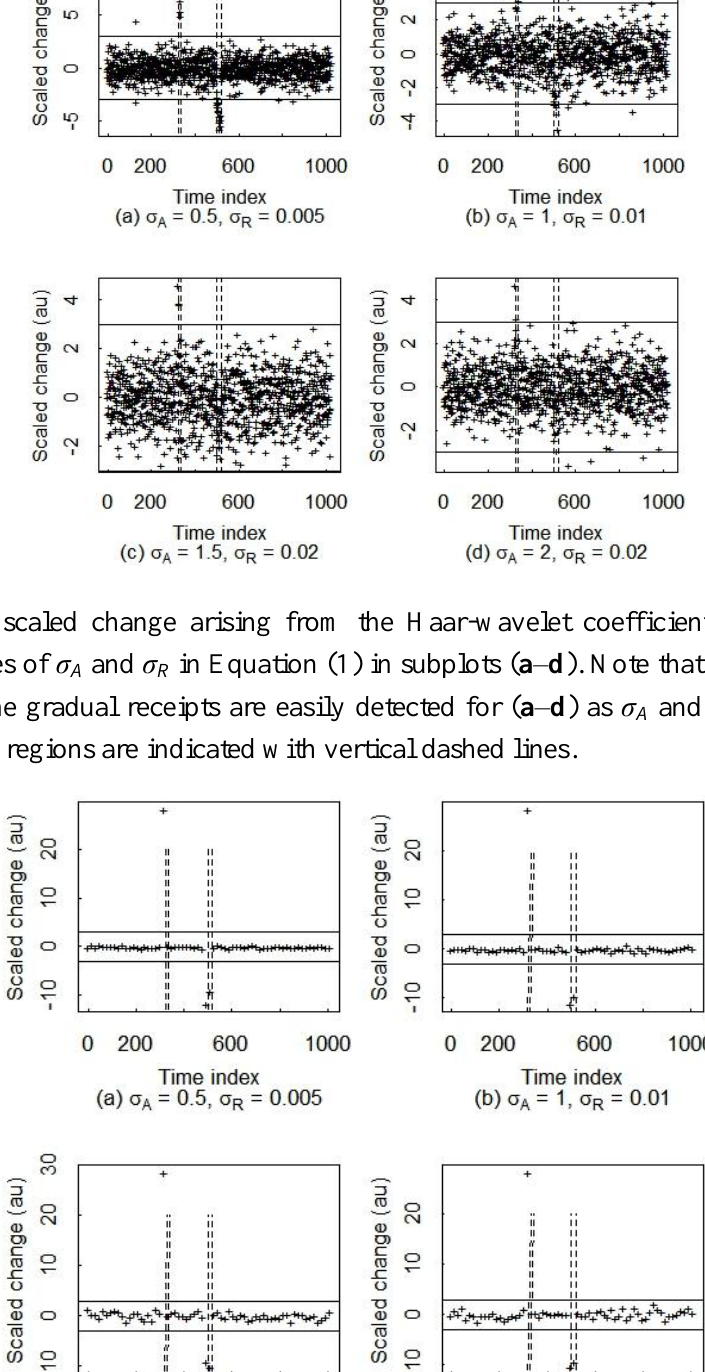
Figure 6. The scaled lag-one change for increasing values of σ Note that the abrupt shipment is easily detected but that the more gradual receipt is less easily detected. The two true change regions are indicated with vertical dashed lines. The values σ and σ in Equation (1) increase in going from subplots ( a ) to ( d ) in Figure 6, A R beginning with σ = 0.5 and σ = 0.005 in ( a ). A R